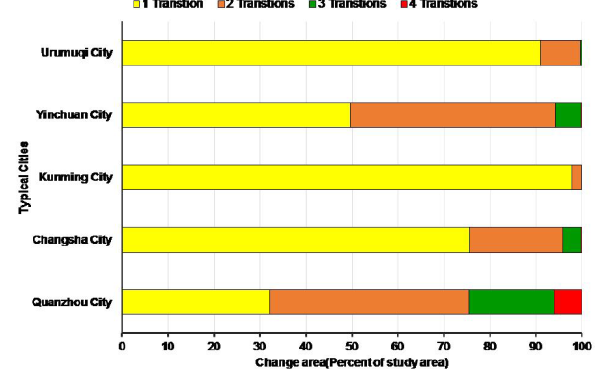
Figure 4. The land use change of Incidents